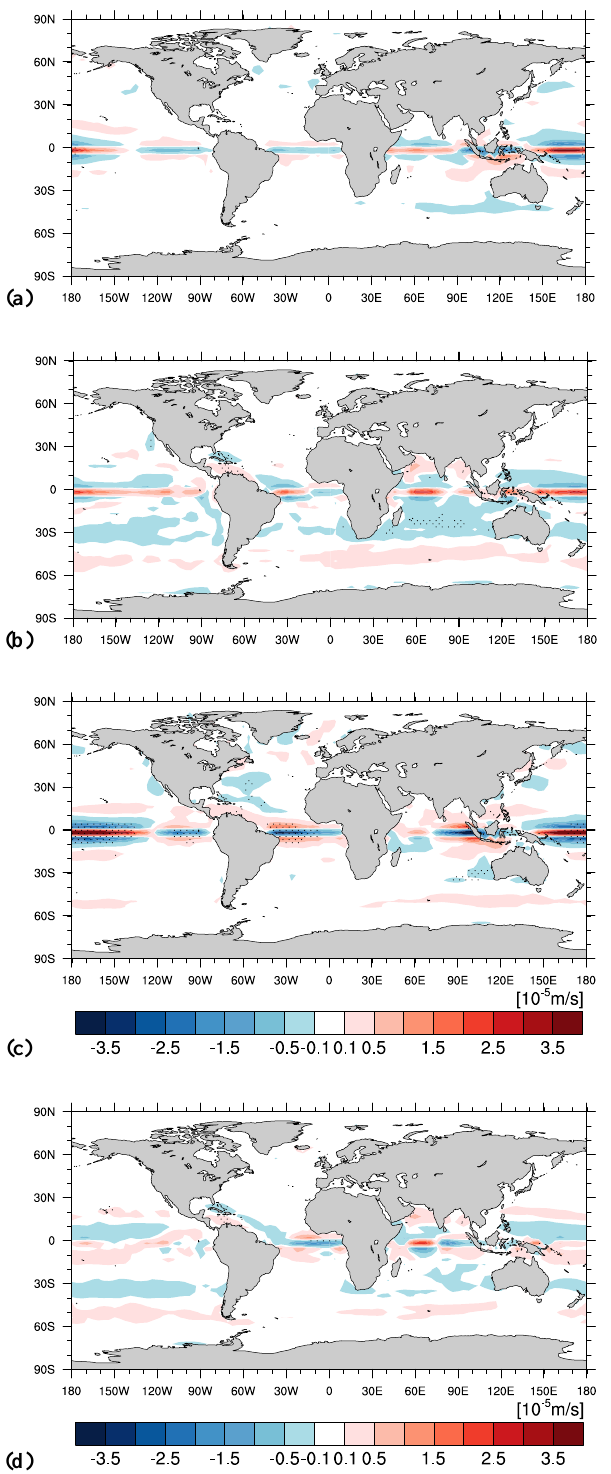
Fig. 6. As Fig. 4, but for Ekman pumping [10 − 6 m/s], for month 12 (a) , 18 (b) , 24 (c) and 30 (d) of the model integration. Positive anomalies indicate an anomalous upward